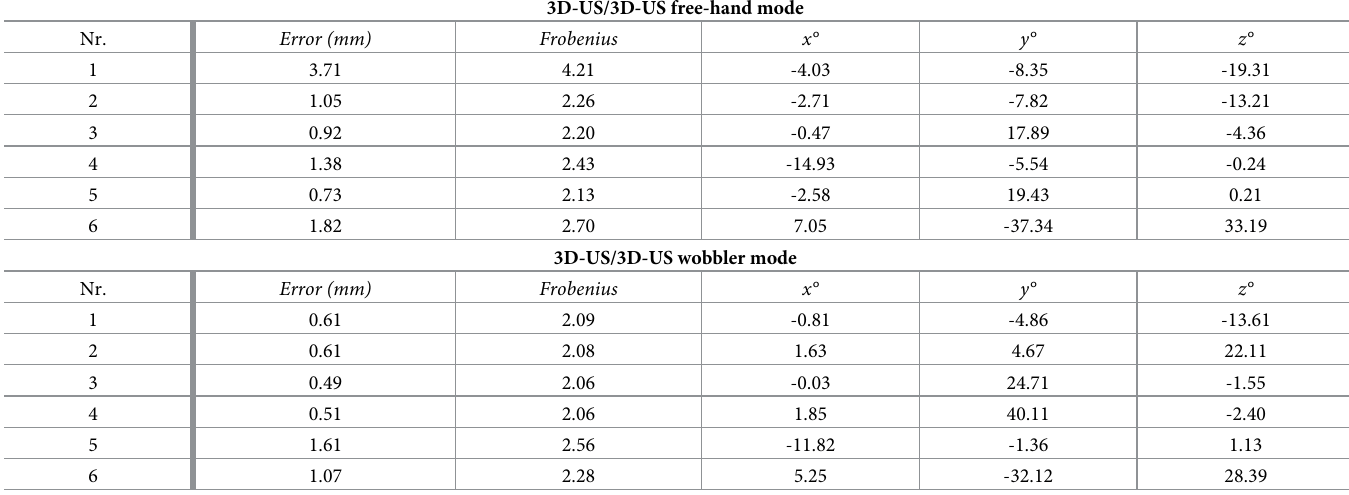
Table 4. The registration error for the 3D free-hand mode and the 3D wobbler mode . Orientations/angles (degree) are relative to the axis of reference position of the transducer, straight in front of the camera. 3D-US/3D-US free-hand mode